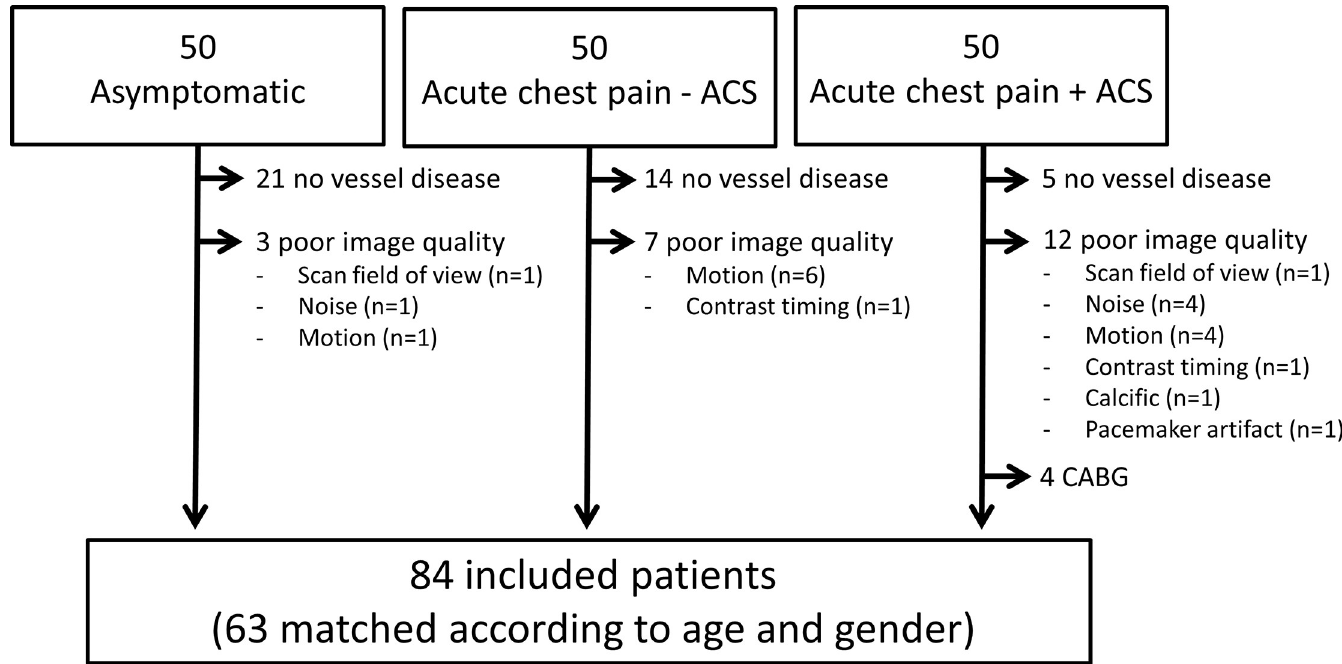
Fig 2. Flow chart of patient inclusion. ACS acute coronary syndrome; CABG coronary artery bypass graft.